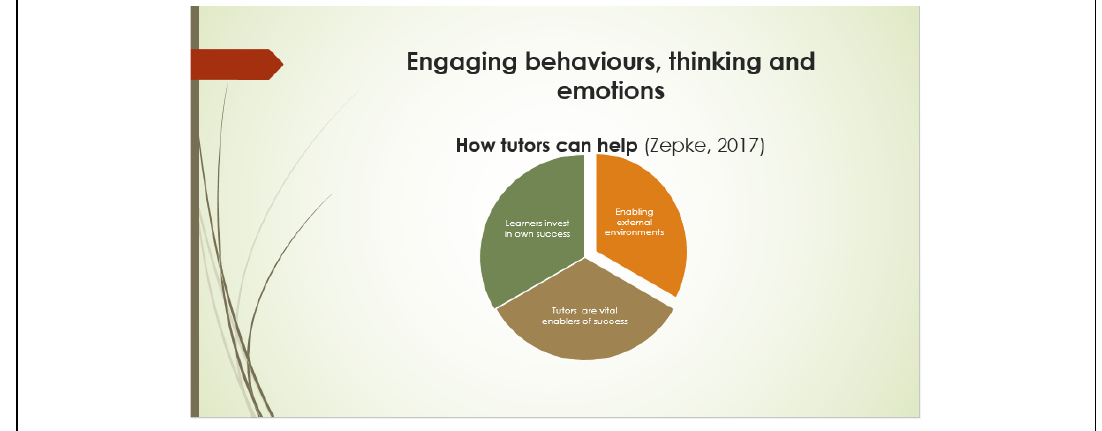
Figure 2: Engaging behaviours, thinking and